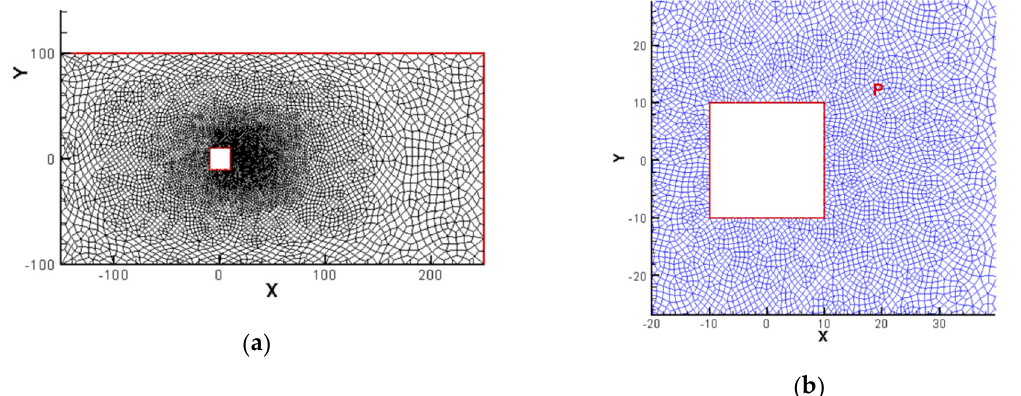
Figure 5. Study domain and computational meshes: ( a ) global view and ( b ) local view around the square obstacle. (unit measurement for x and y axis is m).